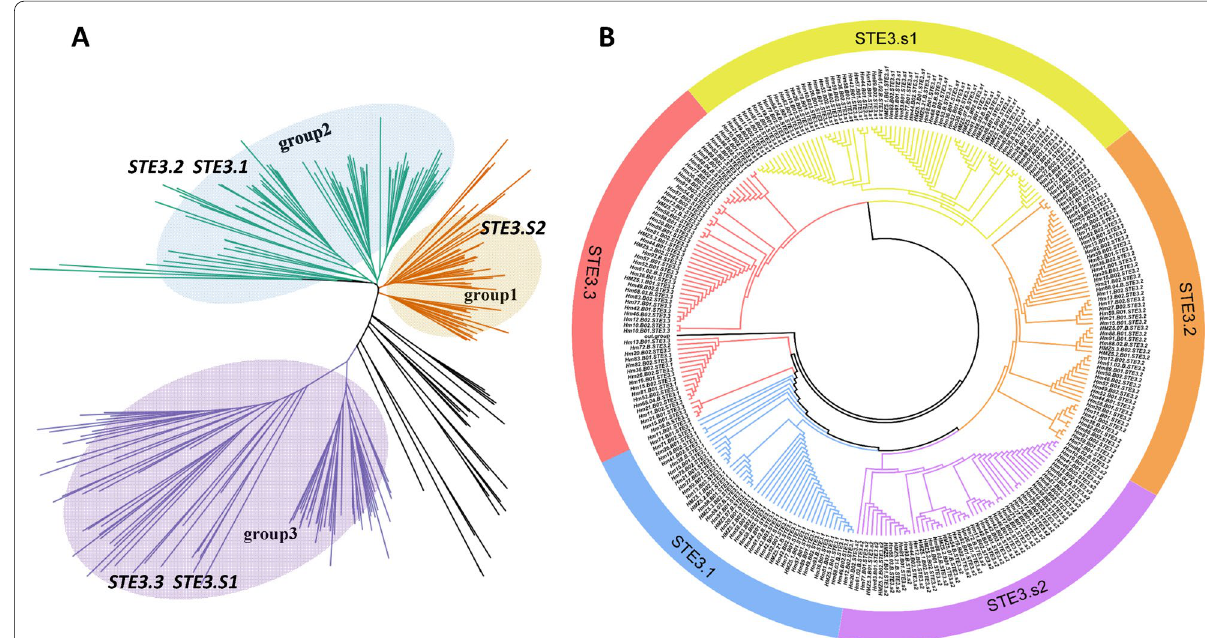
Fig. 6 Phylogenetic tree depicting the relationship between pheromone receptor and pheromone receptor-like proteins. A Interspecific evolutionary tree between pheromone receptor and pheromone receptor-like proteins of Basidiomycete species. STE3.1 , STE3.2 and STE3.s2 clustered in one branch (group 1 and group 2), STE3.3 and STE3.s1 were in another (group 3). B Intraspecific evolutionary tree between pheromone receptor and pheromone receptor-like proteins of H.